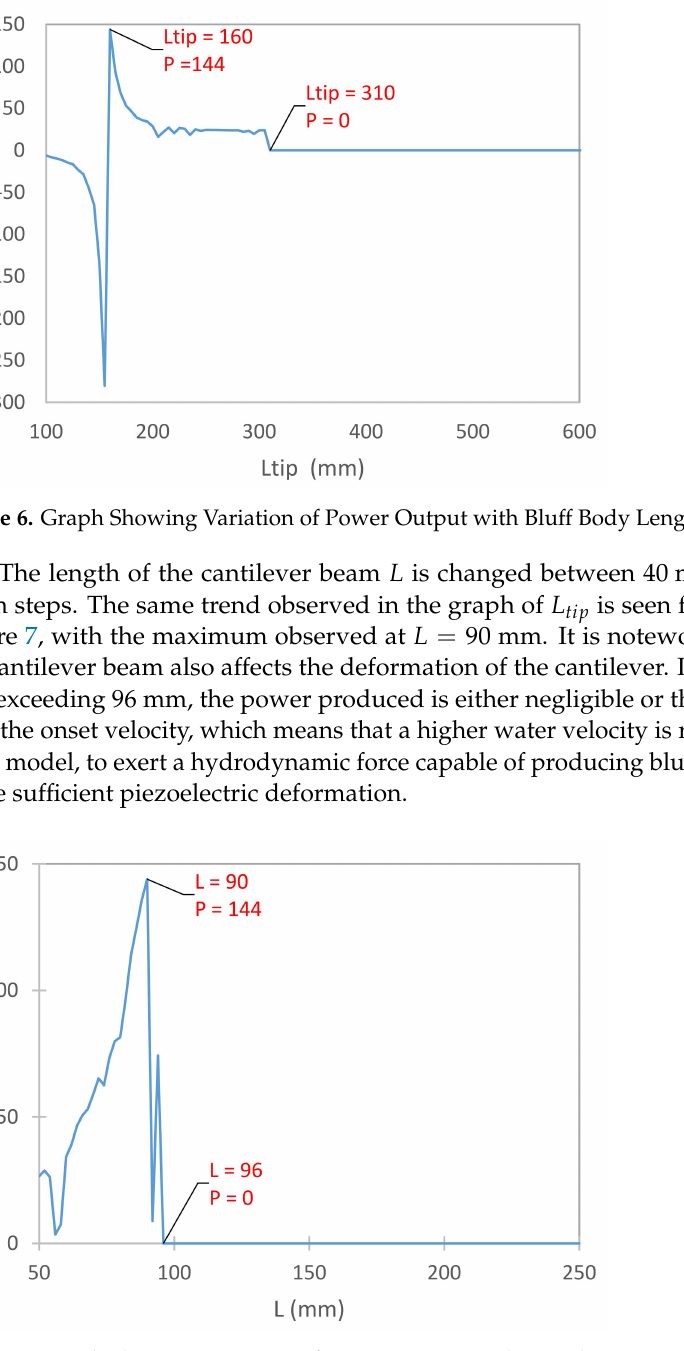
Figure 7. Graph Showing Variation of Power Output with Cantilever Beam Length L . There is noticeable fluctuation in power values as the parameter L 1 (the length between the fixed end of the cantilever beam and the starting point of the piezoelectric layer) is increased from 1 mm to 6 mm by 0.1 mm. This means that the obtained power is highly sensitive to this parameter. A maximum is seen at 4.3 mm in Figure 8. However, the third highest power is observed at 2.5 mm. The difference between the powers at these two values of L 1 is less than 0.0047%. That being said, and given the need to decrease space and budget, the optimal value of L 1 is assumed to be 2.5